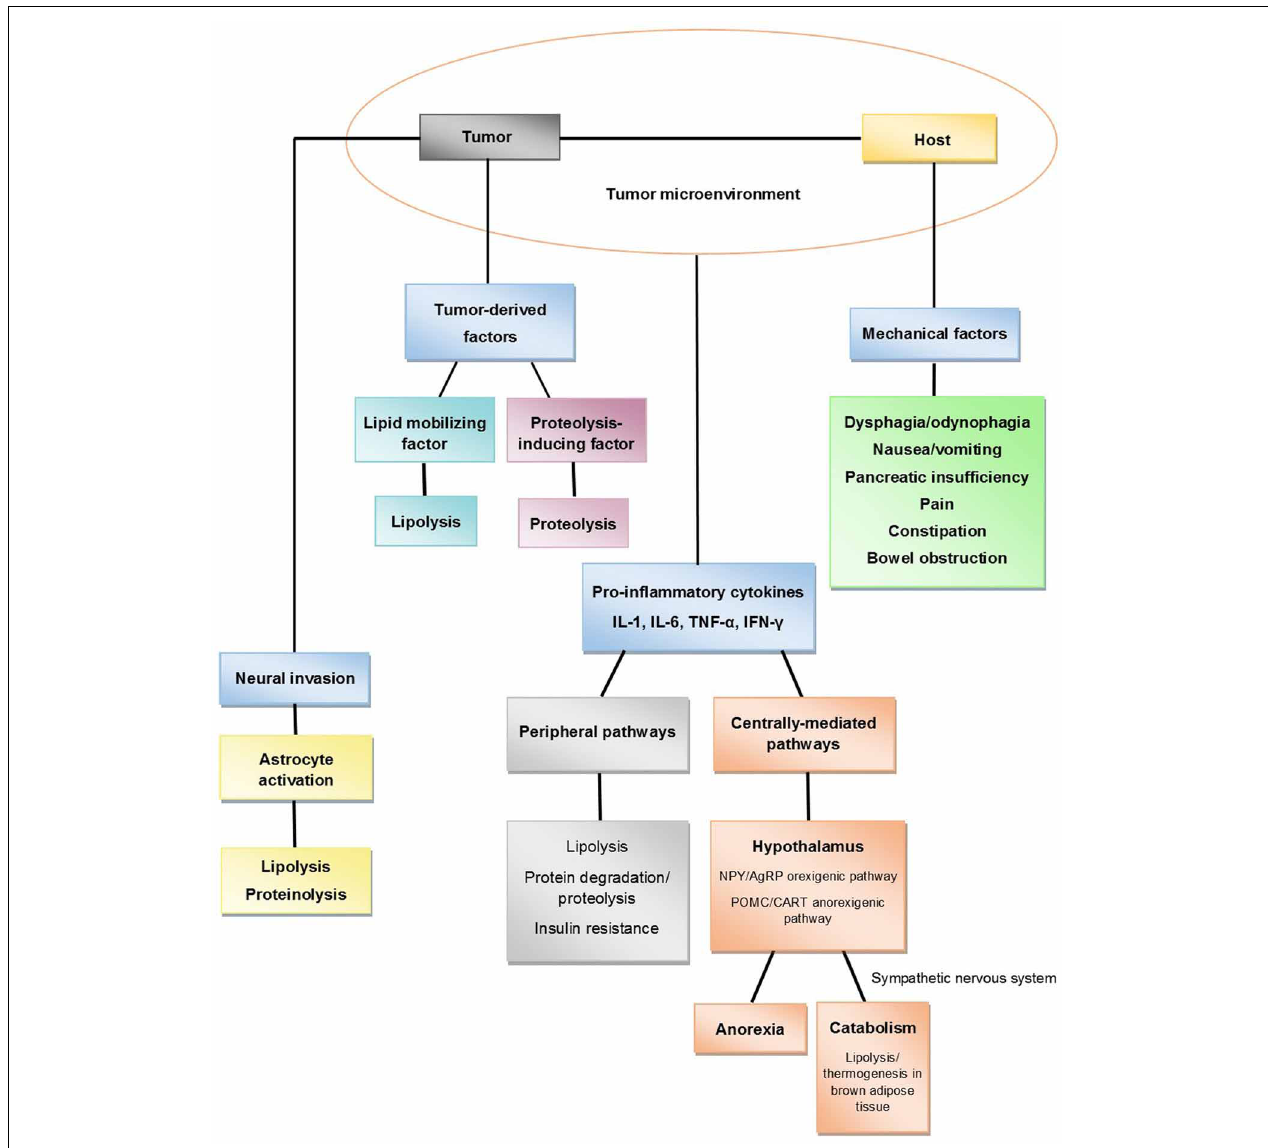
FIGURE 1 | Proposed mechanisms of pancreatic cancer